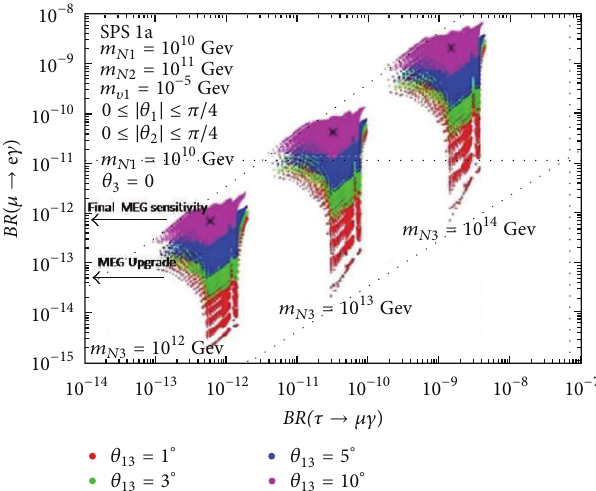
Figure 7: Correlation between the expected 𝜏 → 𝜇𝛾 and 𝜇 → e 𝛾 𝐵𝑅 s in SUSY see-saw models [76] for different values of 𝜃 13 and of the largest of the masses of right handed neutrinos; the measured value of 𝜃 13 is in the range (7 – 10) ∘ [4–6, 11].